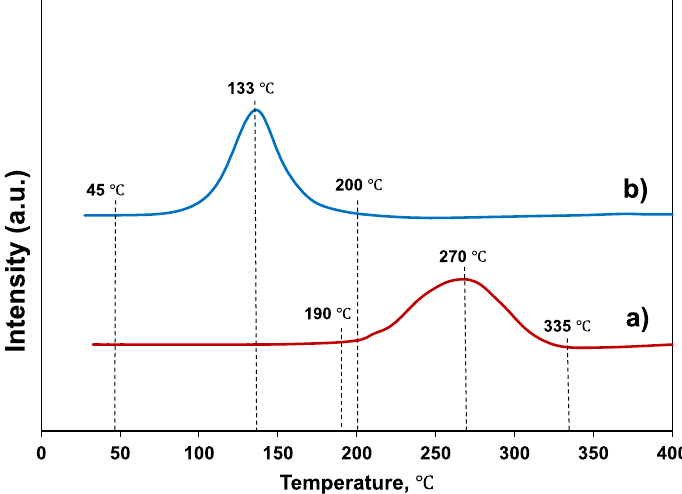
Figure 2. Temperature programmed reduction (TPR) profiles for: ( a ) CZA; ( b ) 2Pd-CZA. CZA: Cu/Zn/Al (molar) = 35/35/30. All traces have been displaced for clarity.